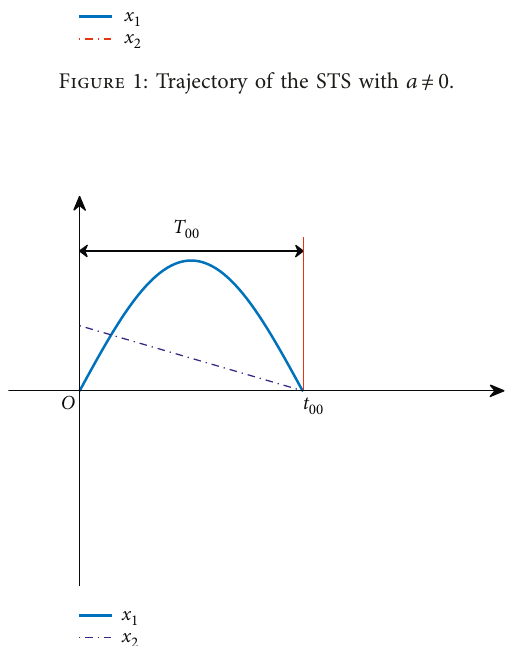
Figure 2: Trajectory of the STS with a � 0.